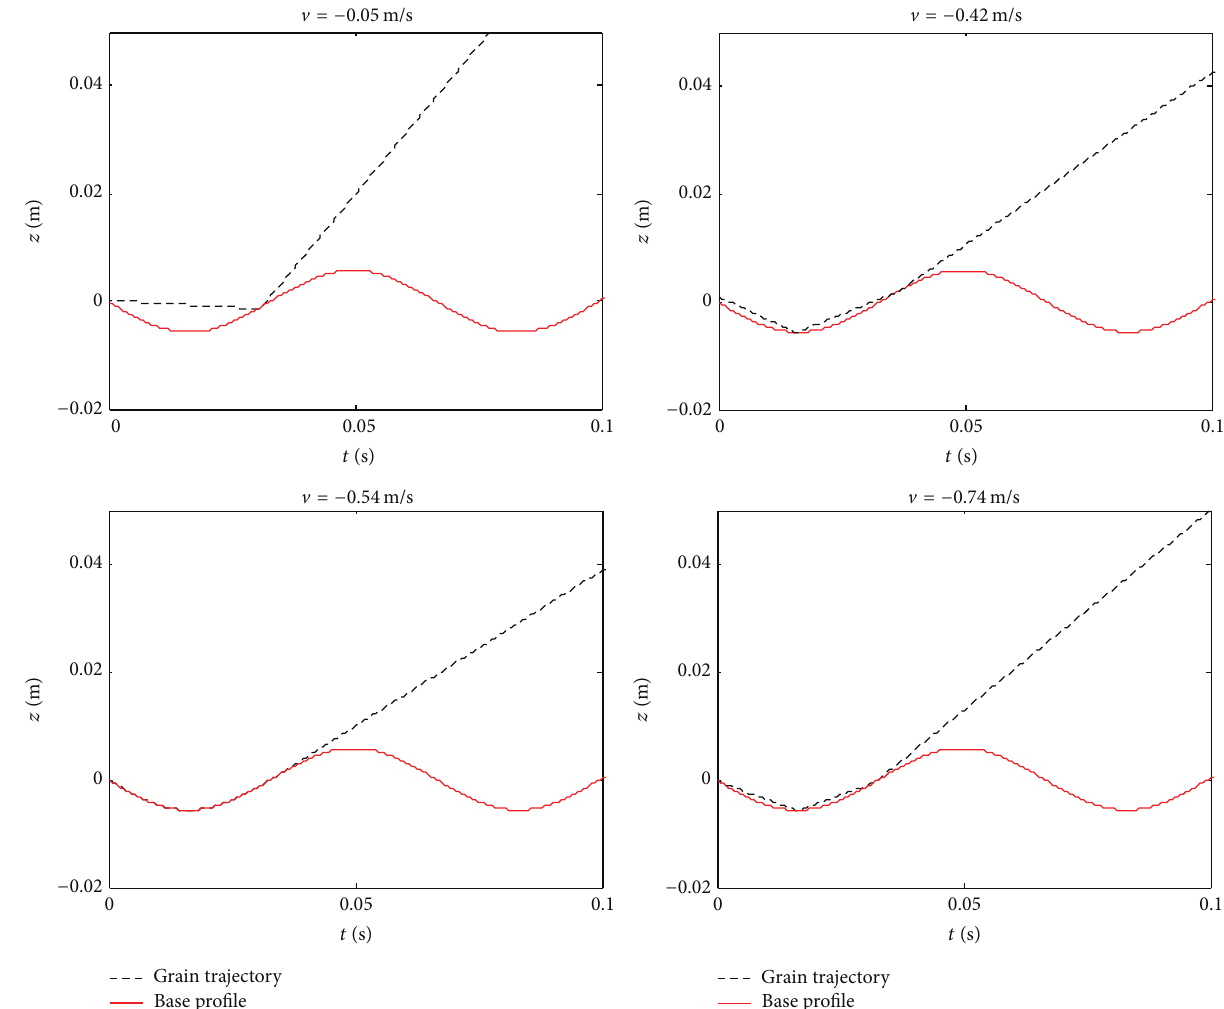
Figure 3: Profiles of a single grain-base interaction at varying incoming grain velocities ( V ) at phase angle of